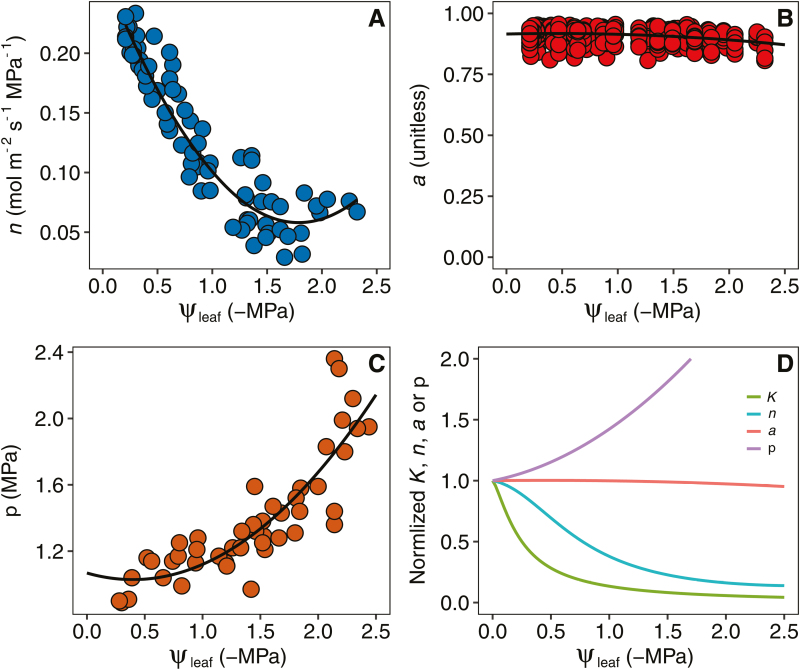
Responses of variables in the stomatal model to changes in leaf water potential (ψleaf). (A) n, a turgor-independent parameter representing the effects of hormonal signals on the sensitivity of guard cell osmotic pressure to leaf turgor. (B) a, the relative concentration of adenosine triphosphate. (C) π, leaf osmotic pressure. (D) The parameters normalized by their values at a ψleaf of 0 MPa. K, gas exchange based EFM estimation of Kleaf, as in Fig. 3C.